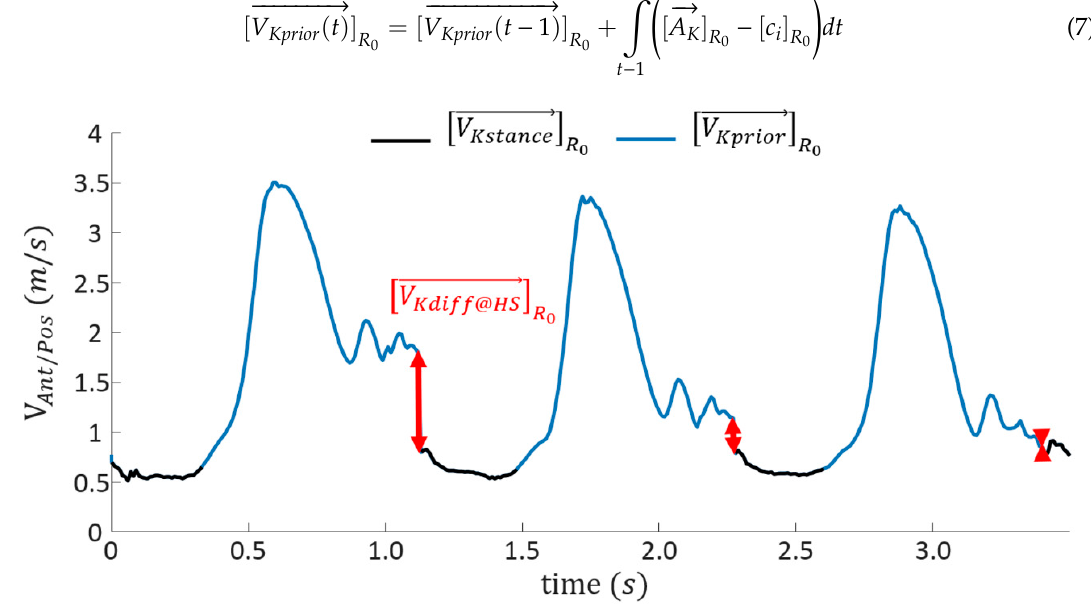
Figure 4. Illustration of a priori correction on an example of anteroposterior component of the knee velocity.